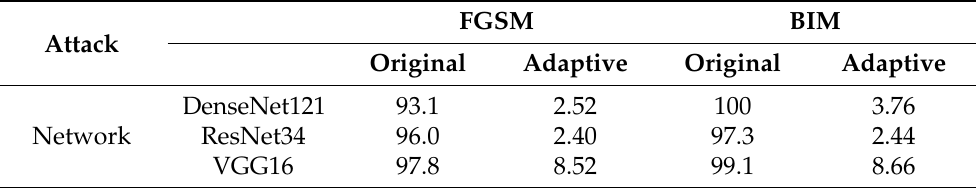
Table 8. Comparison of ASR between original attacks and adaptive attacks. (%) FGSM BIM Attack Original Adaptive Original Adaptive DenseNet121 93.1 Network